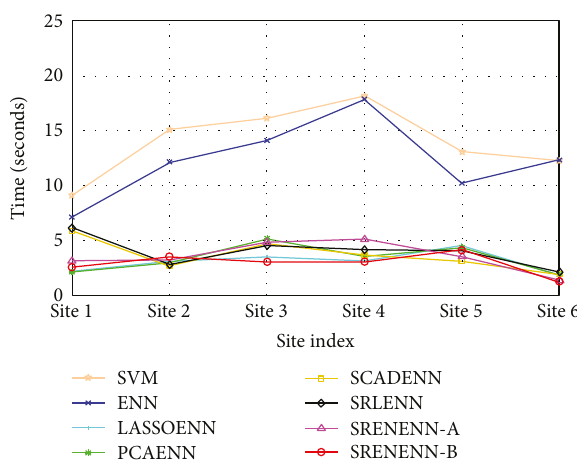
Figure 4: The computation time (in seconds) of eight models. Table 4: The total scores of compared methods for